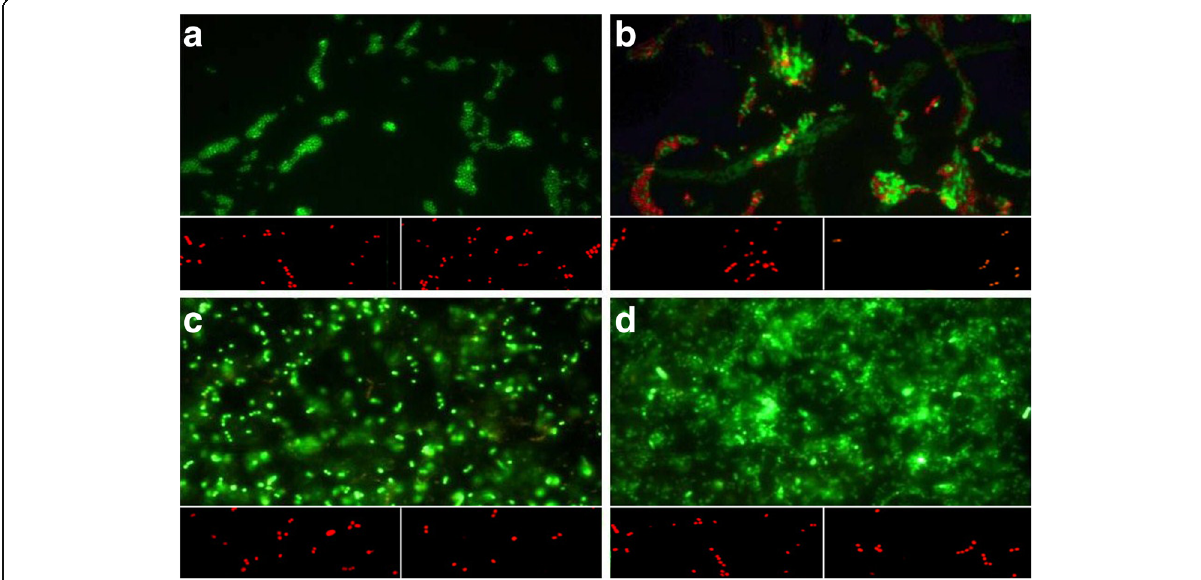
Fig. 2 Representative images of the in vitro mature biofilms on polystyrene at 20 °C ( a ) and 37 °C ( b ) and on stainless steel coupon at 20 °C ( c ) and 37 °C ( d ) of E. hirae ATCC 10541, and the effect of disinfectants LH IDROXI FAST ( inserts on the left ) and LH ENZYCLEAN SPRAY ( inserts on the right ) tested at the same conditions. Biofilms were cultured for 48 h, stained with live/dead reagents, and visualized with the optical microscope fluorescence. Sessile population in biofilms stained in red (propidium iodide) expresses a compromised membrane integrity (damaged), whereas green stained bacteria (SYTO 9) remained viable. Original magnification